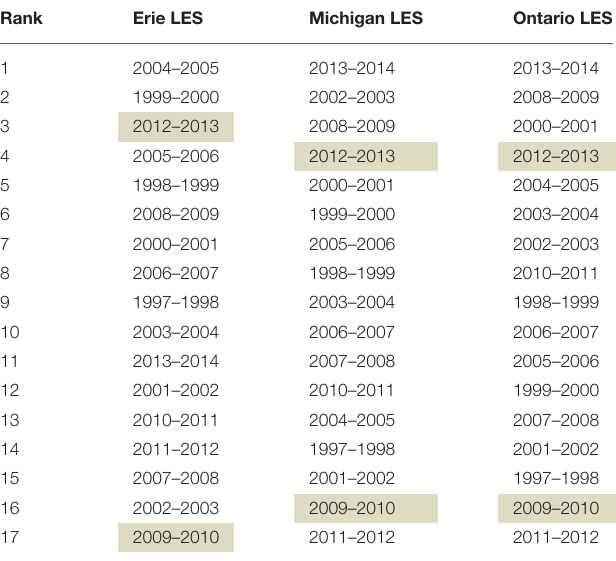
TABLE 1 | Ranking of cold seasons based on the number of LES days for Lakes Erie, Michigan, and Ontario from the 17 cold-season database of Laird et al.